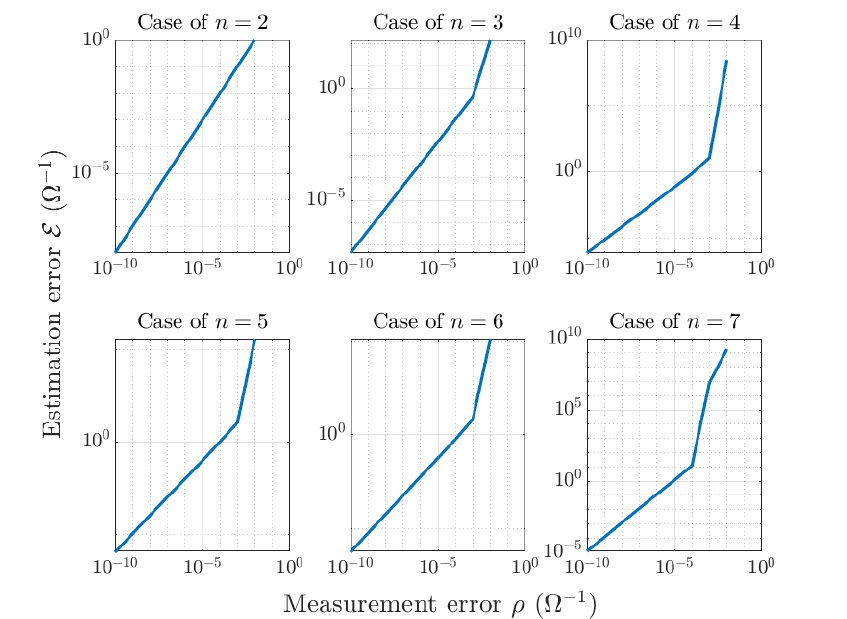
Figure 4. Mismatch in an estimated 2 n -port model resulting from random errors in the data-pairs, with n = 2, 3, 4, 5, 6, 7. (Graphs labelled as in Figure